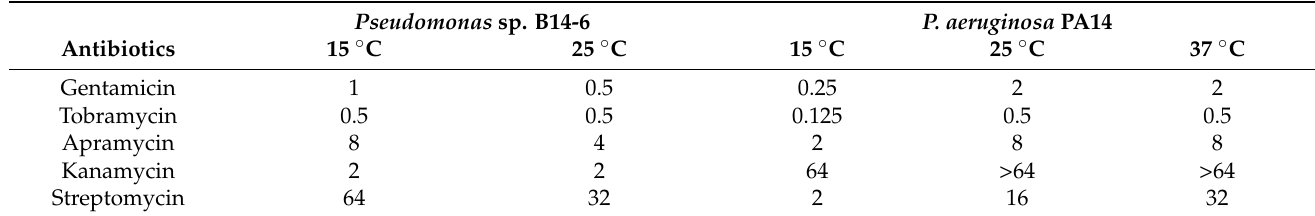
Table 1. Minimum inhibitory concentration ( µ g/mL) at different temperature. Pseudomonas sp.